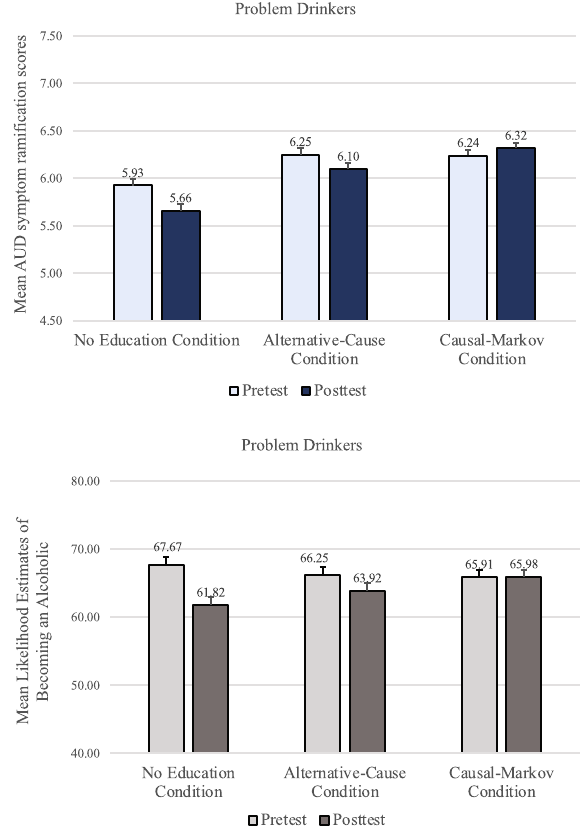
Figure 7. Problem-drinker’s mean AUD symptom ramification scores and mean likelihood estimates of becoming an alcoholic in Study 3, by condition at pre-test and post-test. Error bars represent SEM pairedDiff